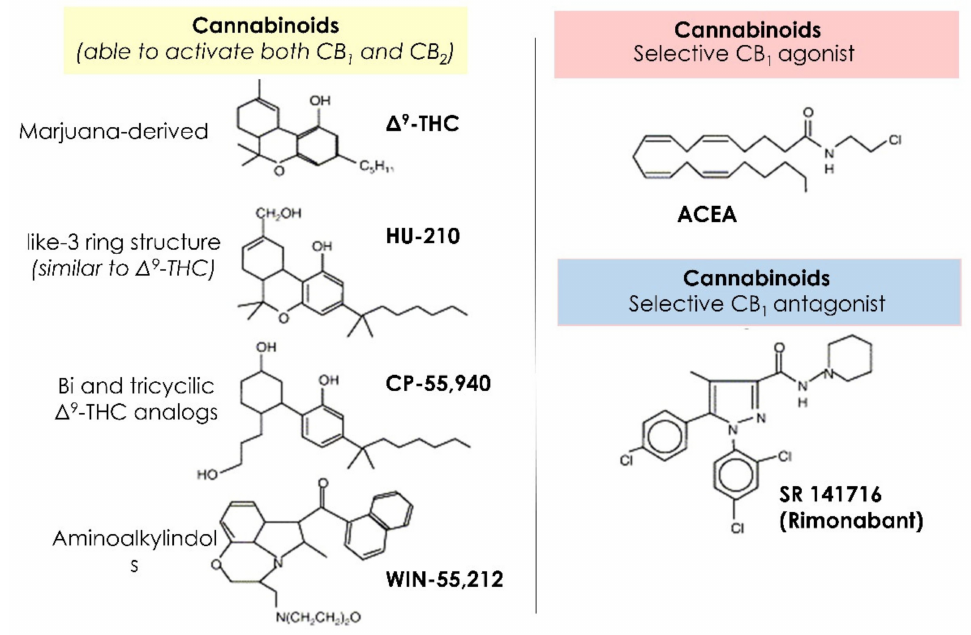
Figure 1. Summary of the main cannabinoids selective for CB 1 and CB 2